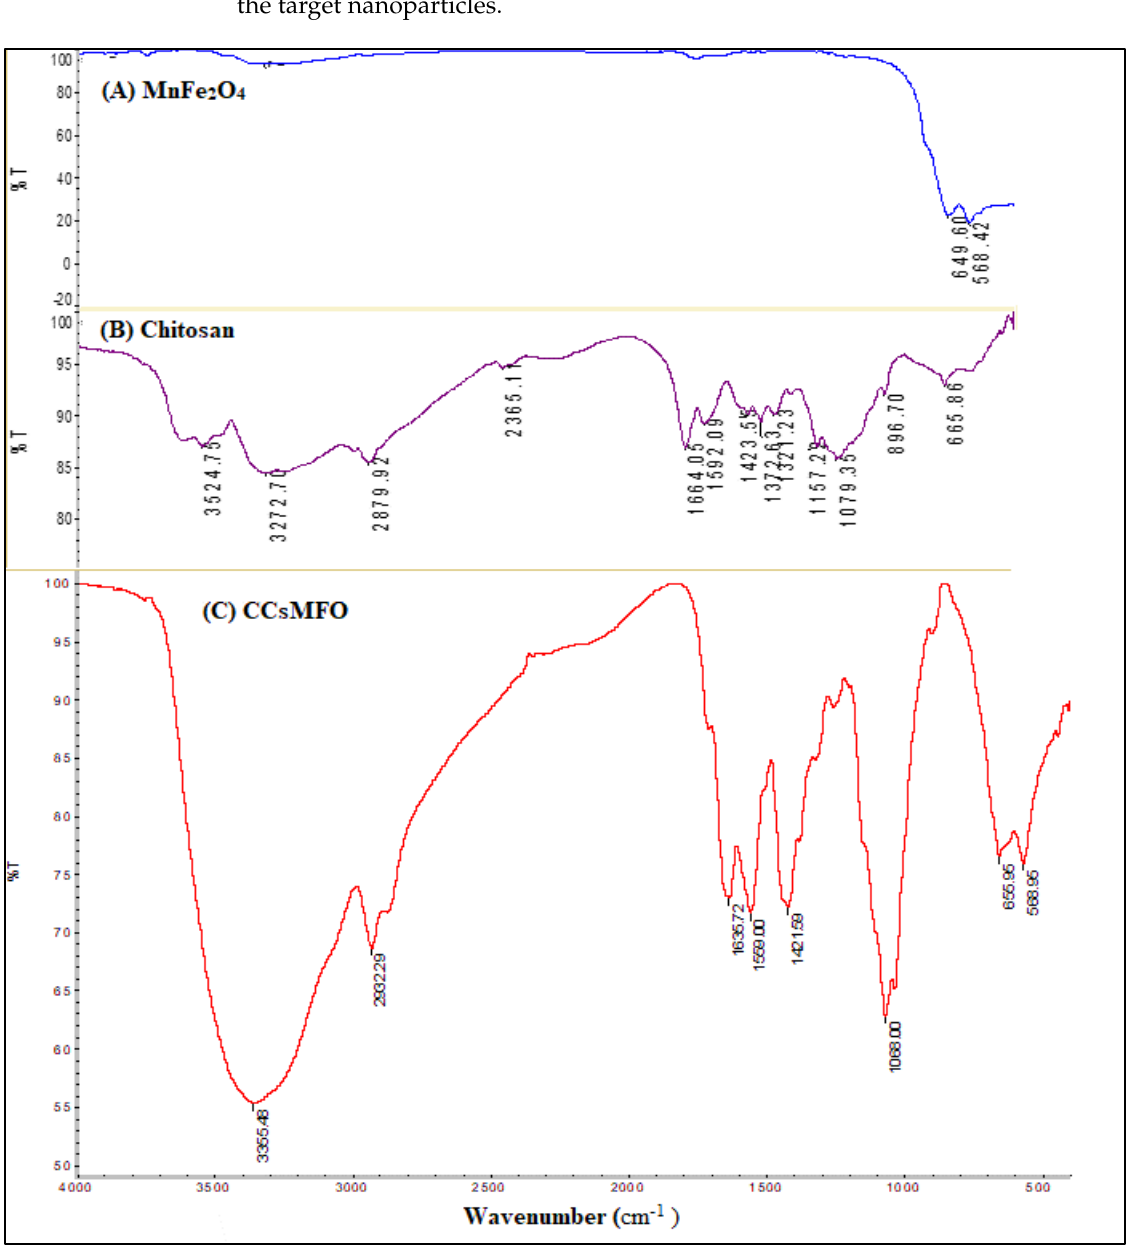
Figure 2. Spectrum of FT-IR for ( A ) MnFe 2 O 4 NPs, ( B ) chitosan, and ( C ) CCsMFO nanocomposite. The diffractogram of MnFe 2 O 4 NPs, chitosan, and (CCsMFO) is given in (Figure 3A–C, respectively). Figure 3A shows the characteristic diffraction peaks of MnFe 2 O 4 NPs with 30.32 ◦ (220), 35.38 ◦ (311), 43.12 ◦ (400), 52.12 ◦ (422), and 57.12 ◦ (511), which is